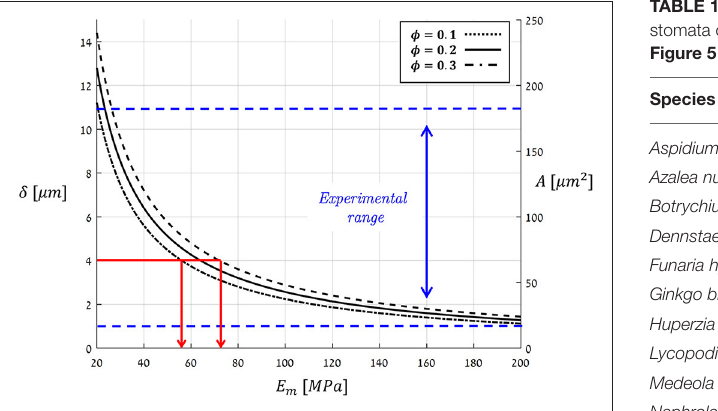
FIGURE 11 | Theoretical predictions for the stomatal aperture ( δ ) and pore area ( A ), as calculated by Equation (12) at a maximal pressure state ( P max 5 [ MPa ]) for a typical range of E m - and φ -values (living plant tissues, = i.e., wet conditions). The range for experimentally measured A - and δ -values for various species of guard cells from literature is indicated by the blue dashed-lines (summarized in Table 1 ). Red lines—the estimation of E m for Ginkgo biloba.